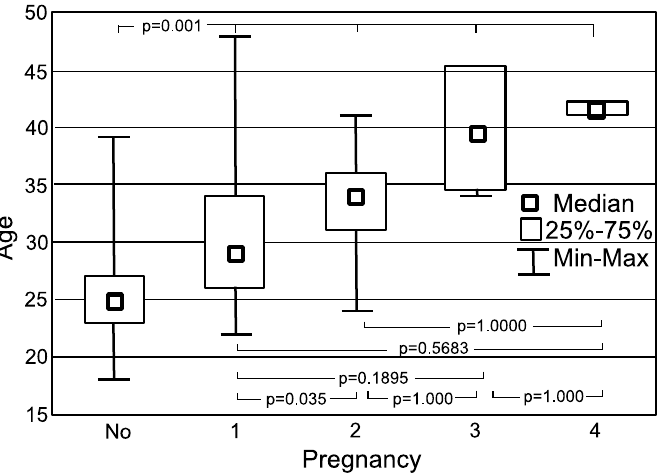
Figure 2. Age by number of pregnancies in the study group.